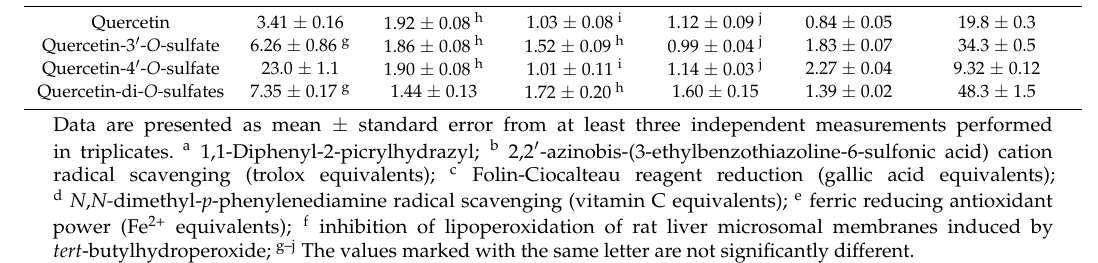
Table 5. Antioxidant capacity of quercetin sulfates in comparison with non-conjugated quercetin.